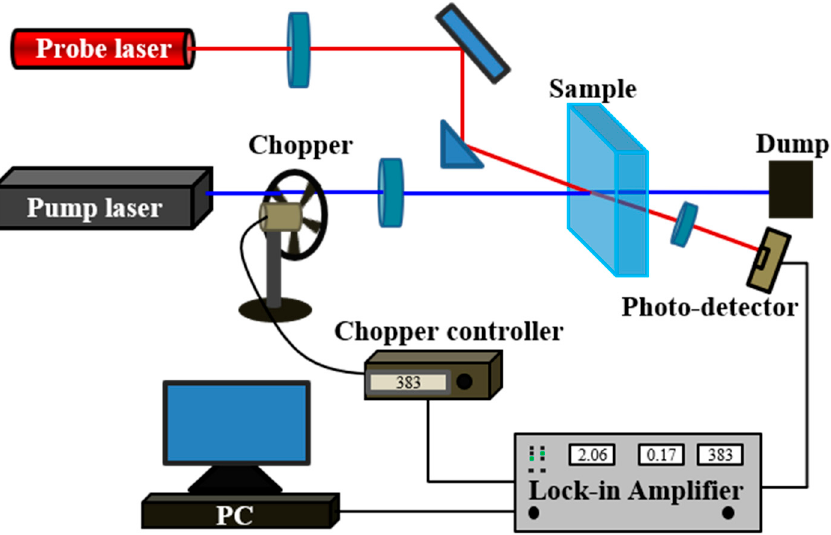
Figure 1. Schematic of the PCI experimental setup for the weak absorption